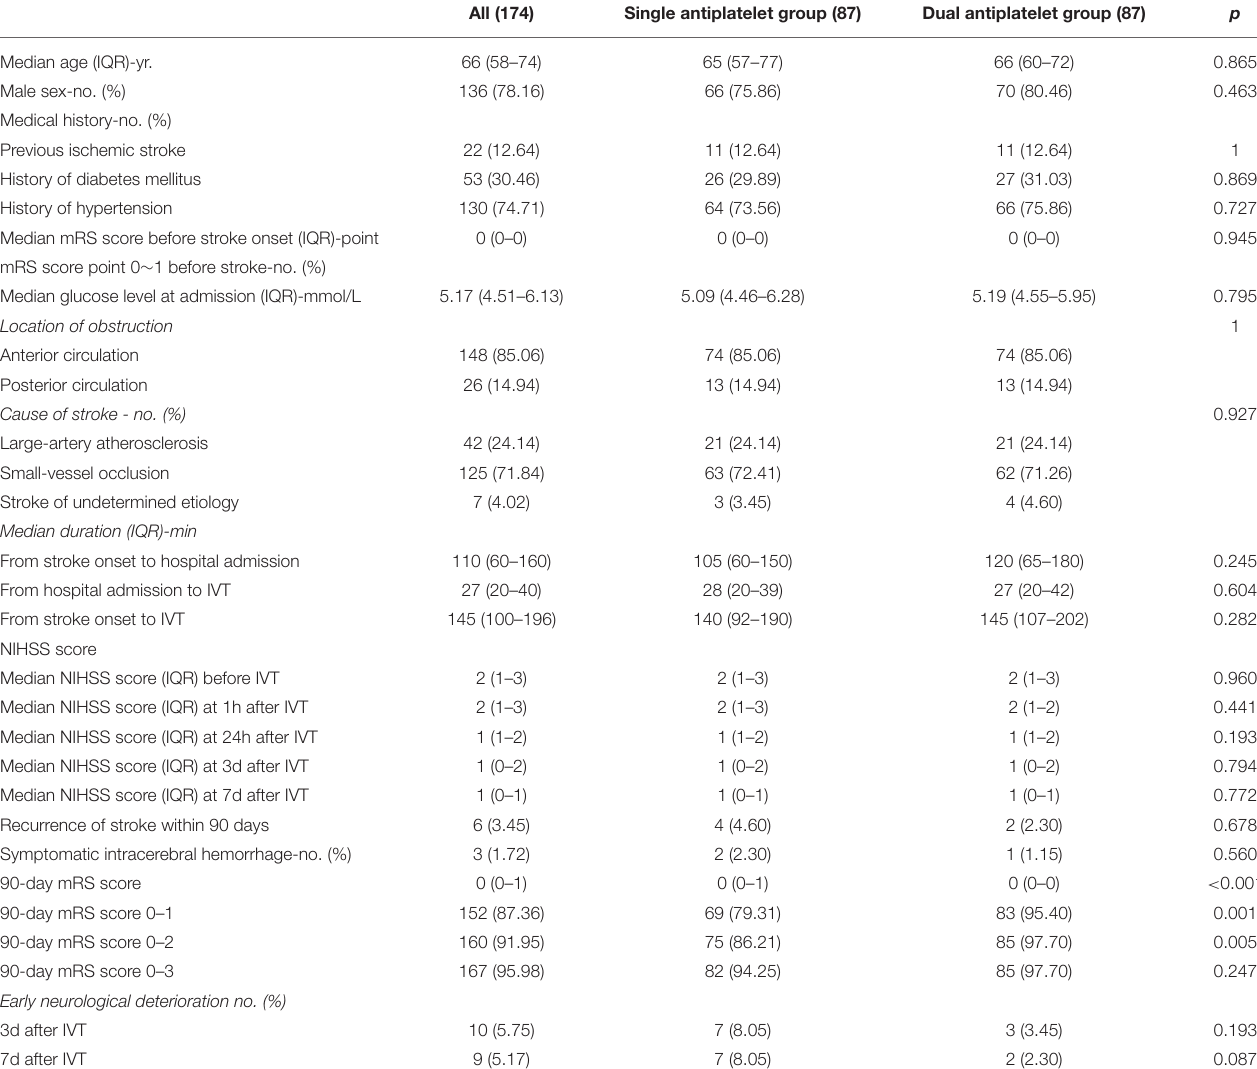
TABLE 4 | Baseline demographic characteristics and outcomes in the matched analyses. All (174) Single antiplatelet group (87) Dual antiplatelet group (87) p Median age